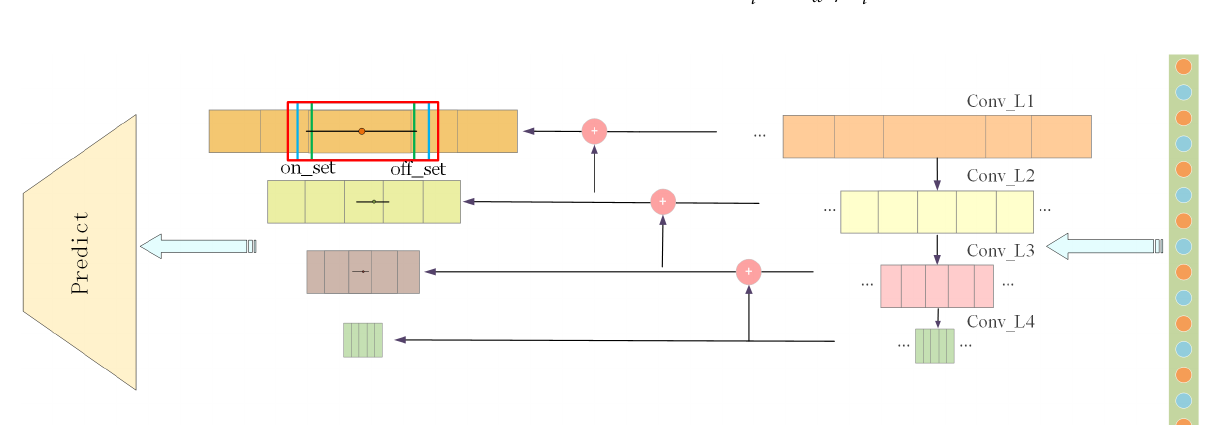
Figure 5. The structure of the clip proposal